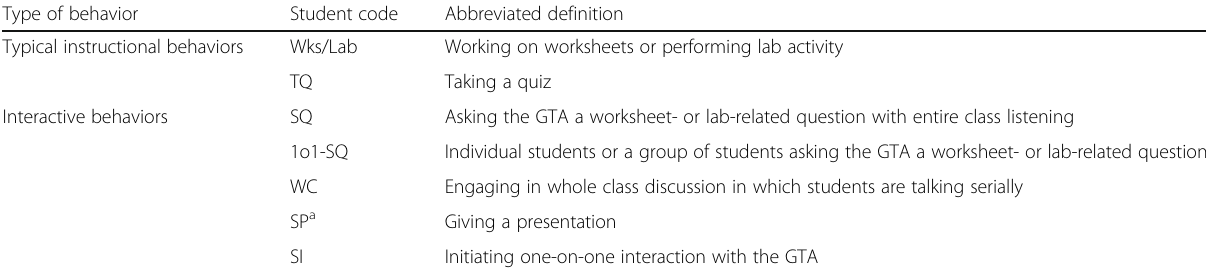
Table 3 Definitions for codes that describe student behaviors Type of